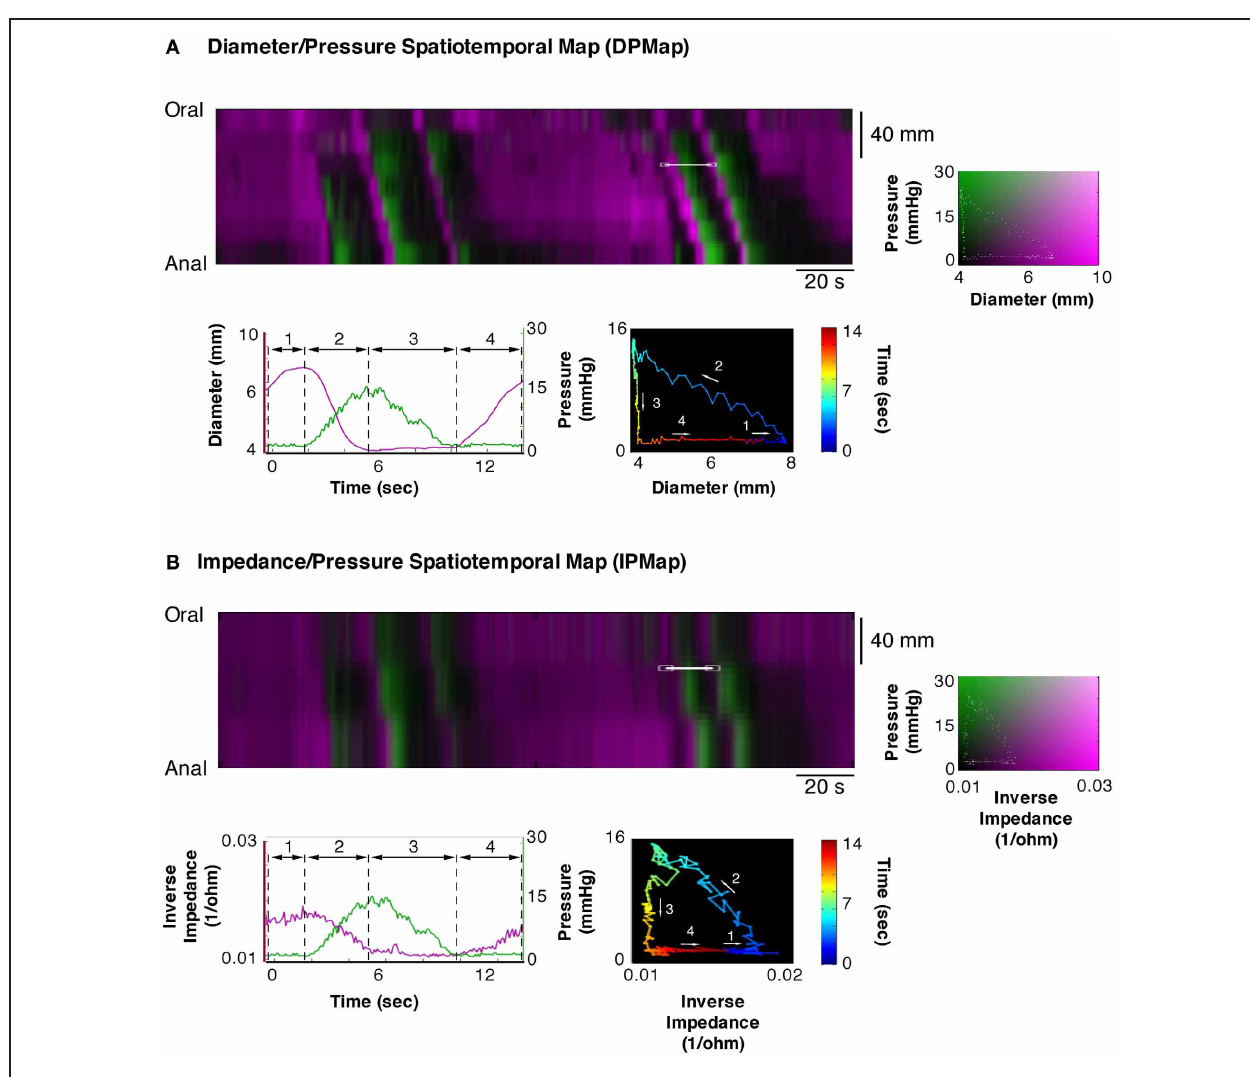
FIGURE 12 | Equivalent composite spatio temporal maps of diameter/pressure (DPMap; A) and impedance/pressure (IPMap; B). Pressure is portrayed in green and diameter (A) and inverse of impedance (B) in magenta. As the impedance catheter also recorded pressure we are